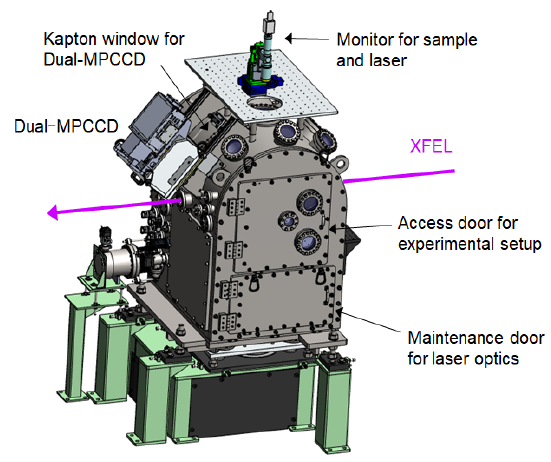
Figure 2. Schematic of the experimental chamber. In the chamber, high-power nanosecond laser, which is focused by a lens with a focal length of 500 mm, irradiates a sample from the bottom side. The laser focusing lens, sample system and a flat panel detector are placed in the chamber. A dual multiport charged coupled device (Dual-MPCCD) detector locates outside the chamber.